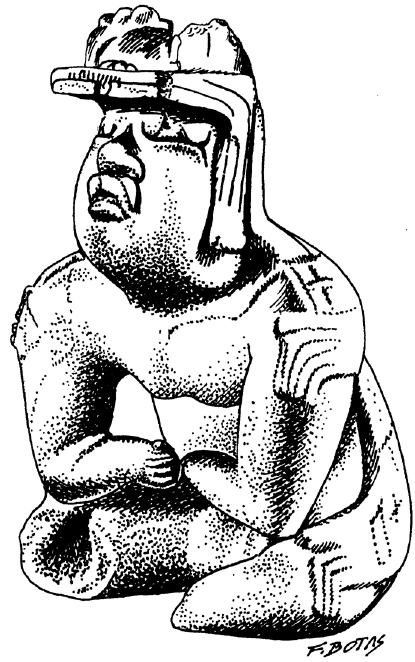
Figure 6: Hollow Olmec style ceramic fi gure, excavated from Atlahuayan, likely dating to the Middle Formative Period. Drawing by Fernando Botas, courtesy of Ann